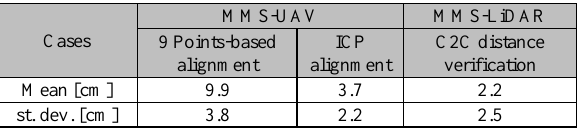
Table 11. Results of the ZEB data alignment employing the Mavic data as reference and validation comparing the ZEB aligned data on the LiDAR one.